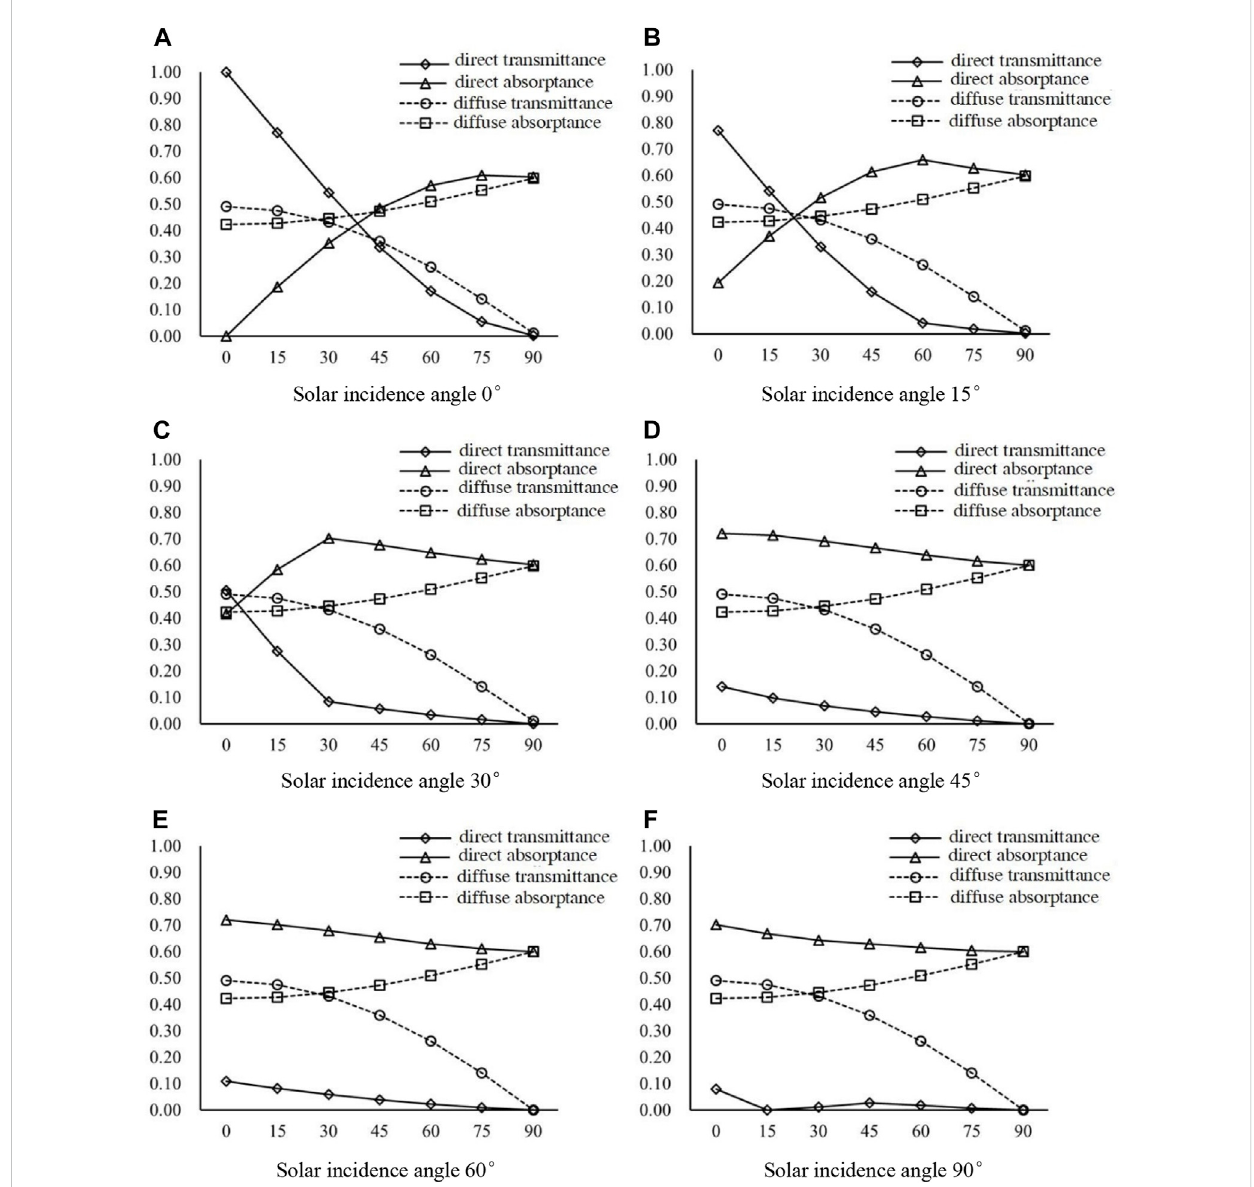
FIGURE 9 Effect of different slat inclination angles on the optical performance of PCM blind. (A) Solar incidence angle 0 ° (B) Solar incidence angle 15 ° (C) Solar incidence angle 30 ° (D) Solar incidence angle 45 ° (E) Solar incidence angle 60 ° (F) Solar incidence angle 90 ° .